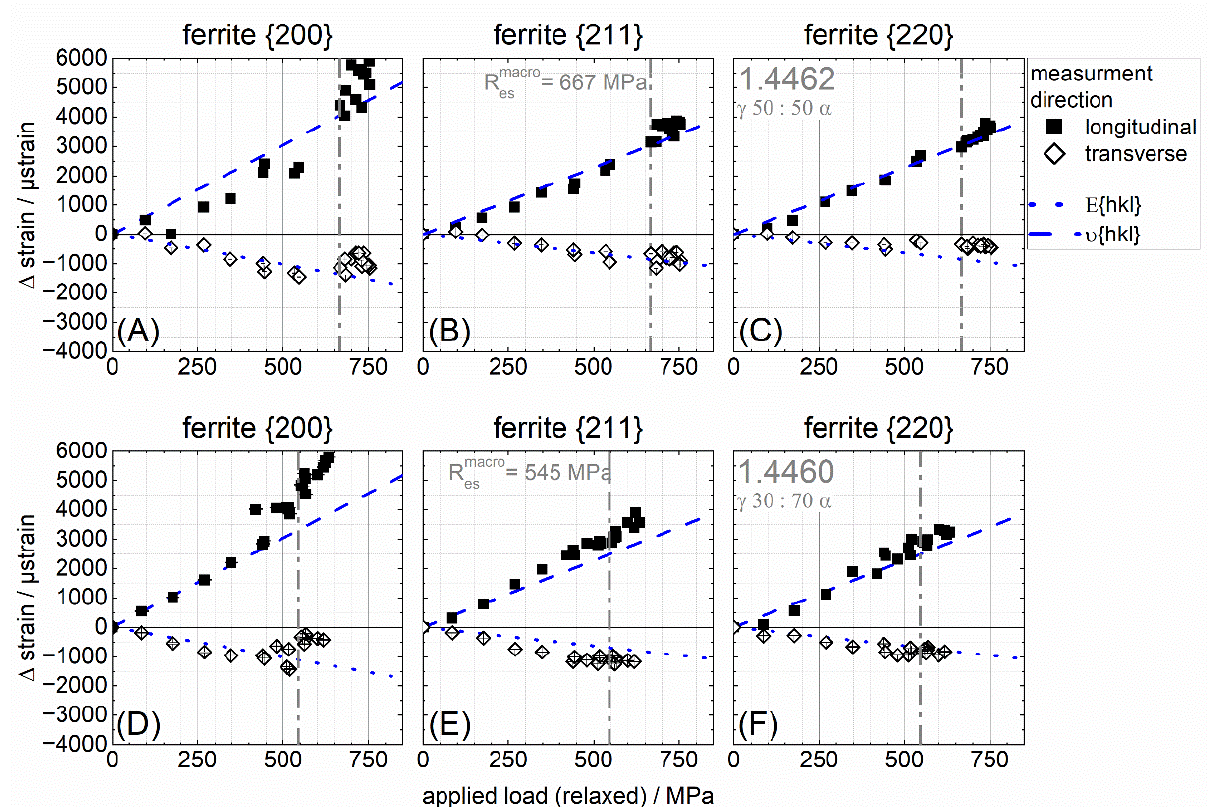
Figure 9. Evolution of lattice strain vs. applied load stress for the ferrite phase in both duplex stainless steels. ( A – C ) Duplex stainless steel 1.4462; ( D – F ) steel 1.4460.